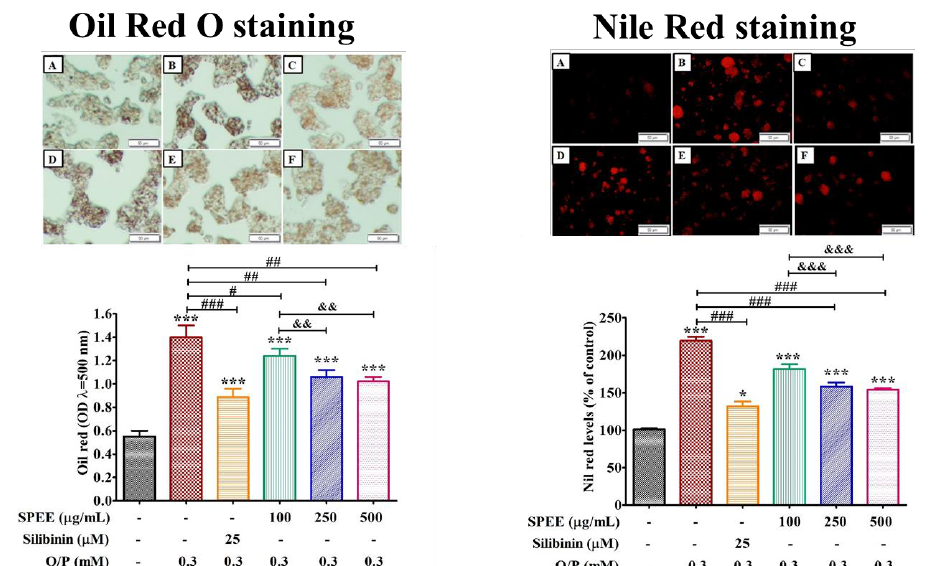
Figure 4. The effects SPEE on O/P-induced intracellular lipid accumulation analyzed by Oil Red O staining and Nile red staining in HepG2 cell. HepG2 cells were co-treated with 0.3 mM O/P and SPEE at 100, 150 and 500 μ g/mL, respectively, for 24 h. Silibinin (25 μ M) was used as the positive control. Oil-Red-stained cells were observed under inverted microscope and Nile-red-stained cells were assessed by phase-contrast fluorescence microscopy (magnification, ×200). ( A ) Control, ( B ) O/P 0.3 mM, ( C ) O/P 0.3 mM + Silibinin 25 µM, ( D ) O/P 0.3 mM + SPEE 100 μ g/mL, ( E ) O/P 0.3 mM + SPEE 250 μ g/mL and ( F ) O/P 0.3 mM + SPEE 500 μ g/mL. Values are expressed as the mean ± SD ( n = 3). * p < 0.05 and *** p < 0.001 vs. the control group. # p < 0.05, ## p < 0.01 and ### p < 0.001 vs. the O/P group. && p < 0.01 and &&& p < 0.001 vs. the O/P 0.3 mM + SPEE 100 µ g/mL group.